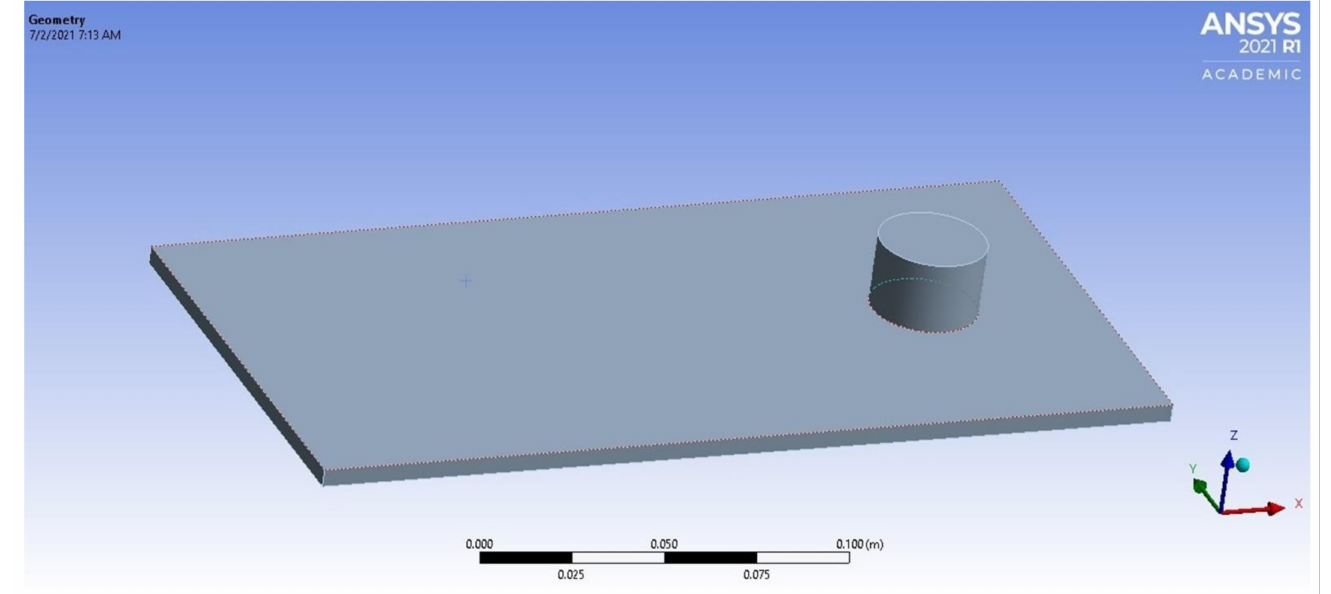
Figure 9. The modified shape of the plate.